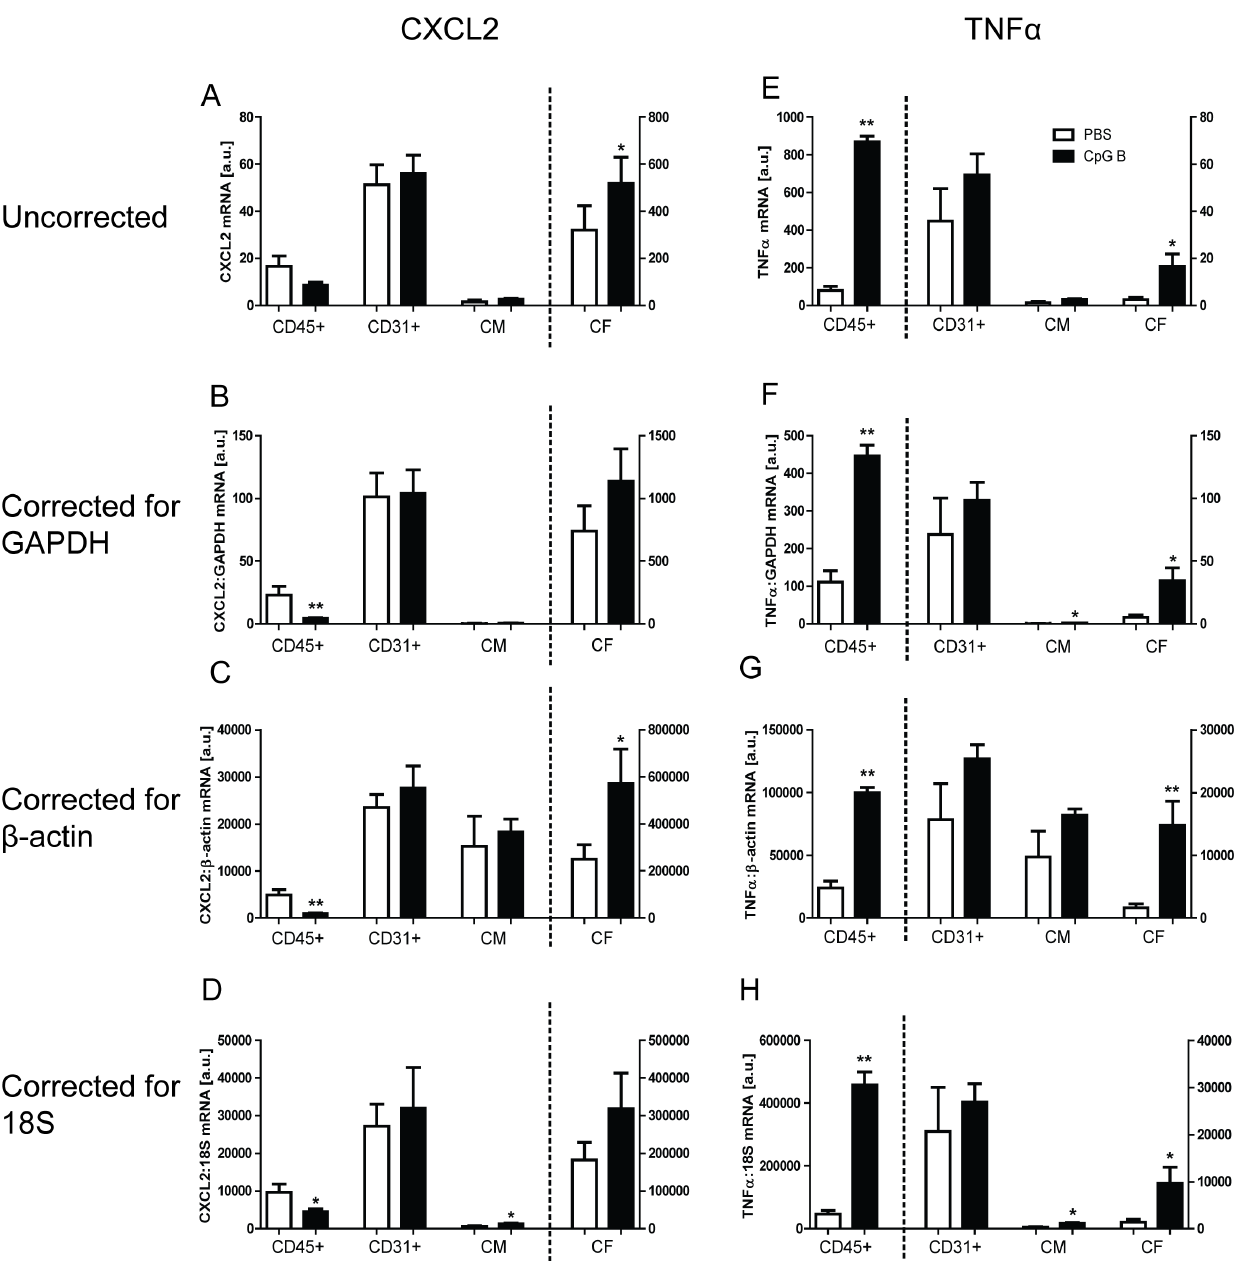
Figure 5. Invivo cardiac TLR9-stimulated cellular responses. Male C57BL/6 mice were injected i.p. with 100 m l CpG B (50 m g; n=6, black bars) or vehicle (n=6, white bars) and euthanized after 24 hours, with subsequent isolation of cardiac myocytes (CM), CD45 + , CD31 + and non-CM/non- CD45 + /non-CD31 + (denominated CF). TLR9-mediated responses in the cell-fractions were analyzed by mRNA expression levels of CXCL2 (panels A–D) and TNF a (panels E–H). Uncorrected data are shown in panels A and E. CXCL2 and TNF a are also presented as corrected for GAPDH (panels B and F), b -actin (panels C and G) and 18S (panels D and H). Data presented as mean 6 SEM. * p , 0.05 vs. sham, ** p , 0.01 vs. sham.